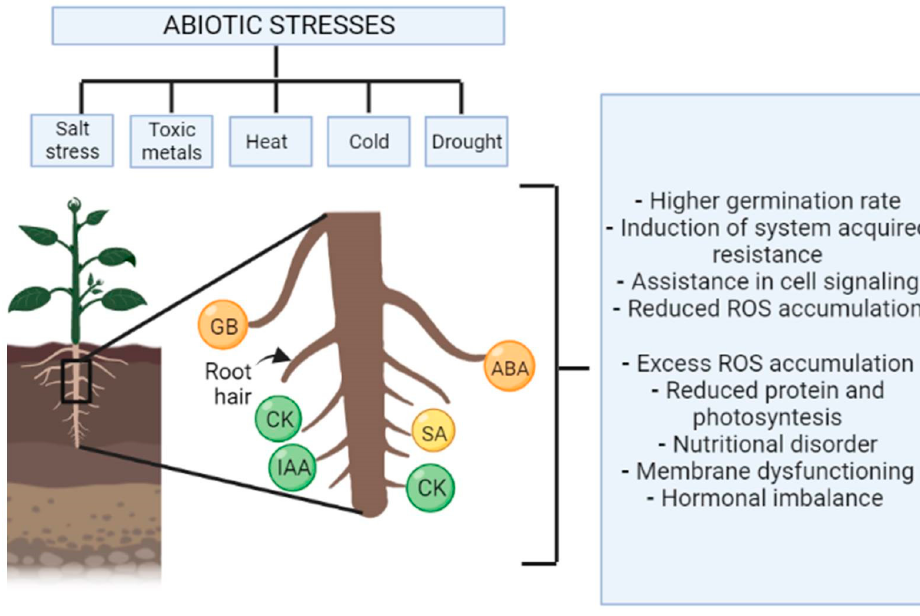
Figure 4. Plant stress-tolerance mechanisms mediated by microbial phytohormones.